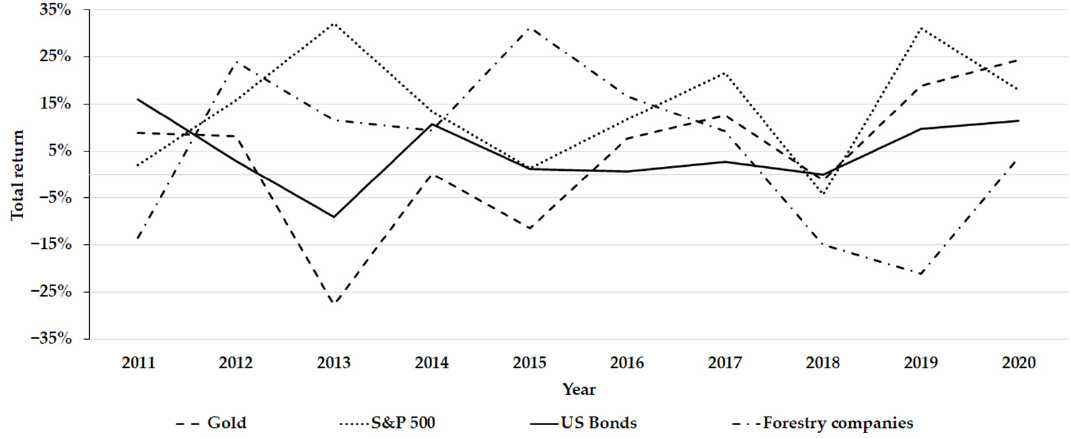
Figure 3. Comparison of total returns in the observed forestry sector to returns of gold investment, the S&P500 index, and U.S. Treasury bonds index.